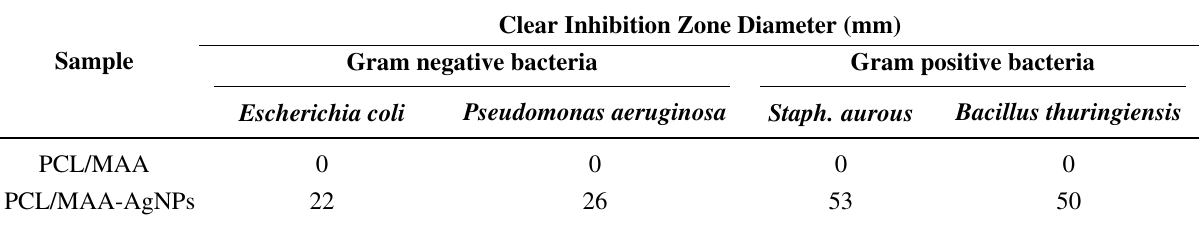
Table 2. Clear inhibition zone diameter (mm) of electrospun PCL/MAA graft copolymer nanofibers without and with AgNPs against human pathogenic bacteria.